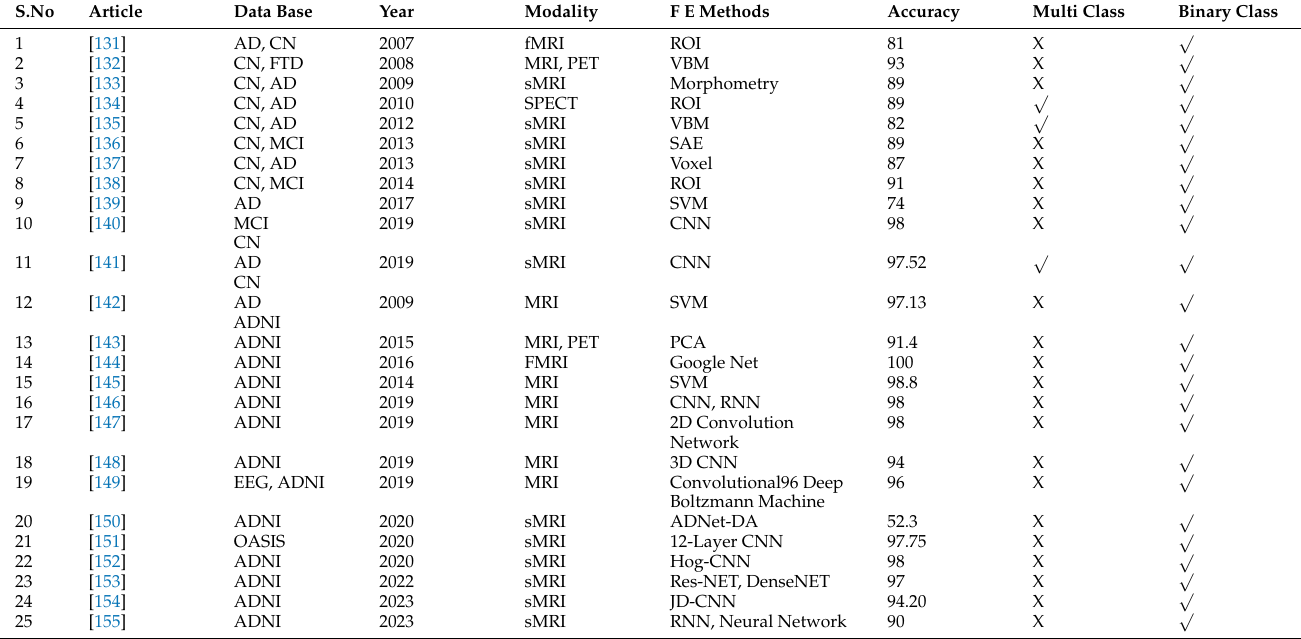
Table 7. An analysis of the different classification methods for